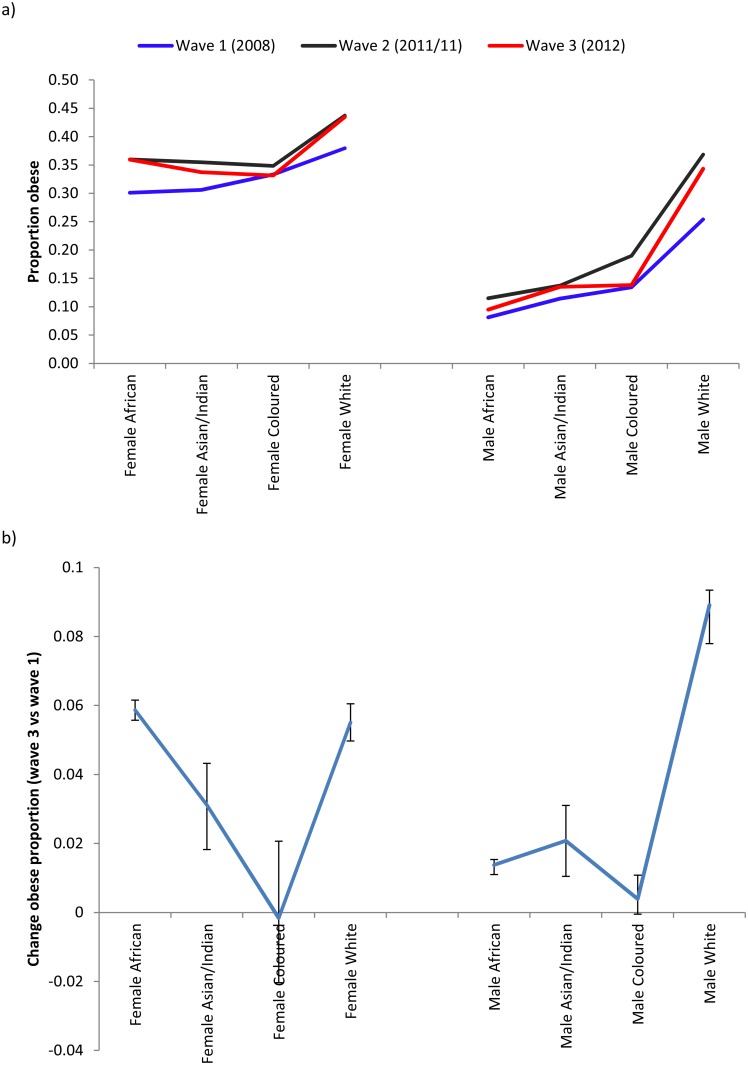

a) Trends in obesity prevalence by ethnicity, gender and period b) Change in obesity prevalence by ethnicity and gender comparing 2012 to 2008.